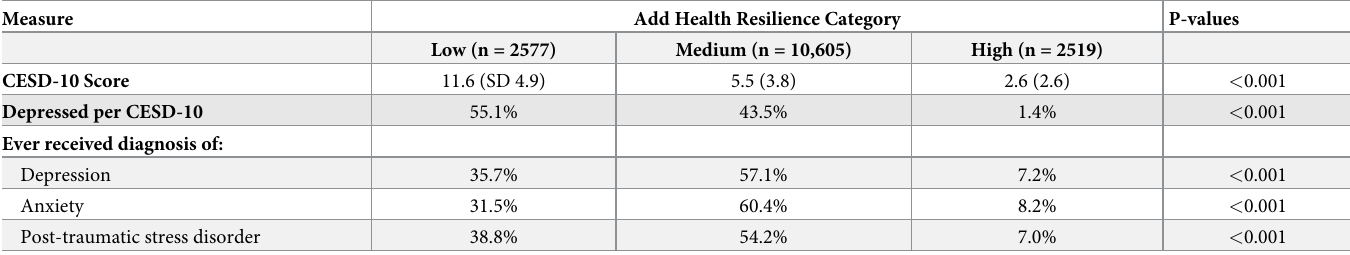
Table 5. Summary of construct validity